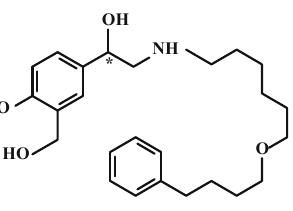
Figure 7: Structure of salmeterol.